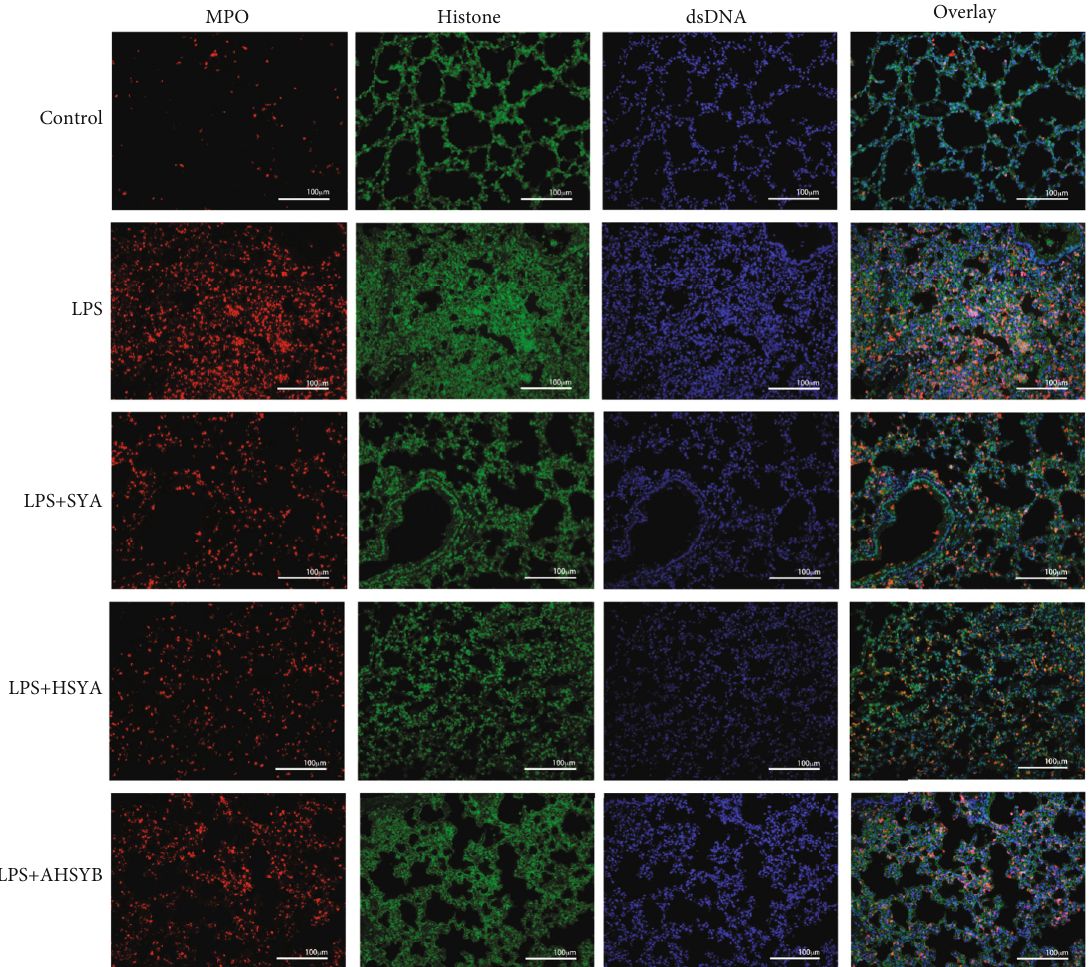
Figure 5: E ff ects of SYA, HSYA, and AHSYB on LPS-induced lung NET production in the lungs (MPO: red; histone: green; dsDNA: blue; bar = 100 μ m).